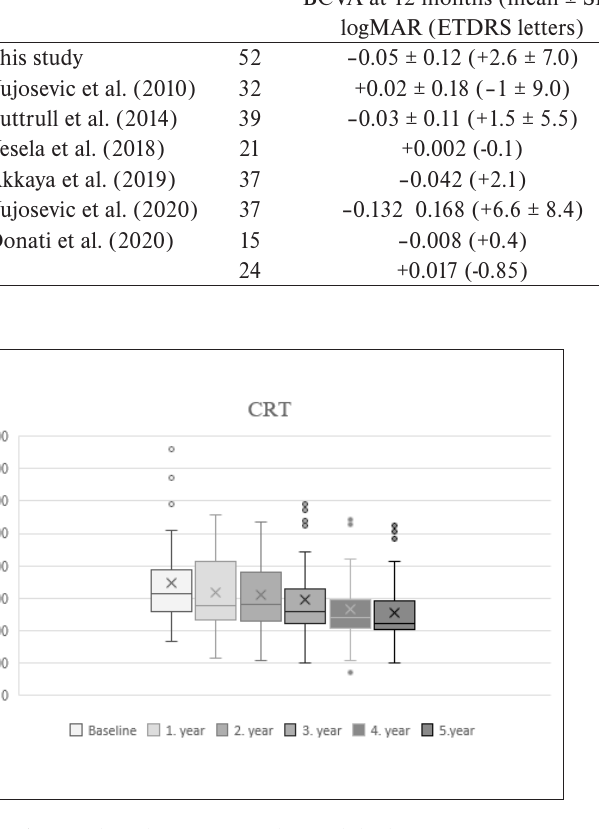
Fig. 1. Box-plots showing central retinal thickness (CRT) (µm), 5-year long monitoring.